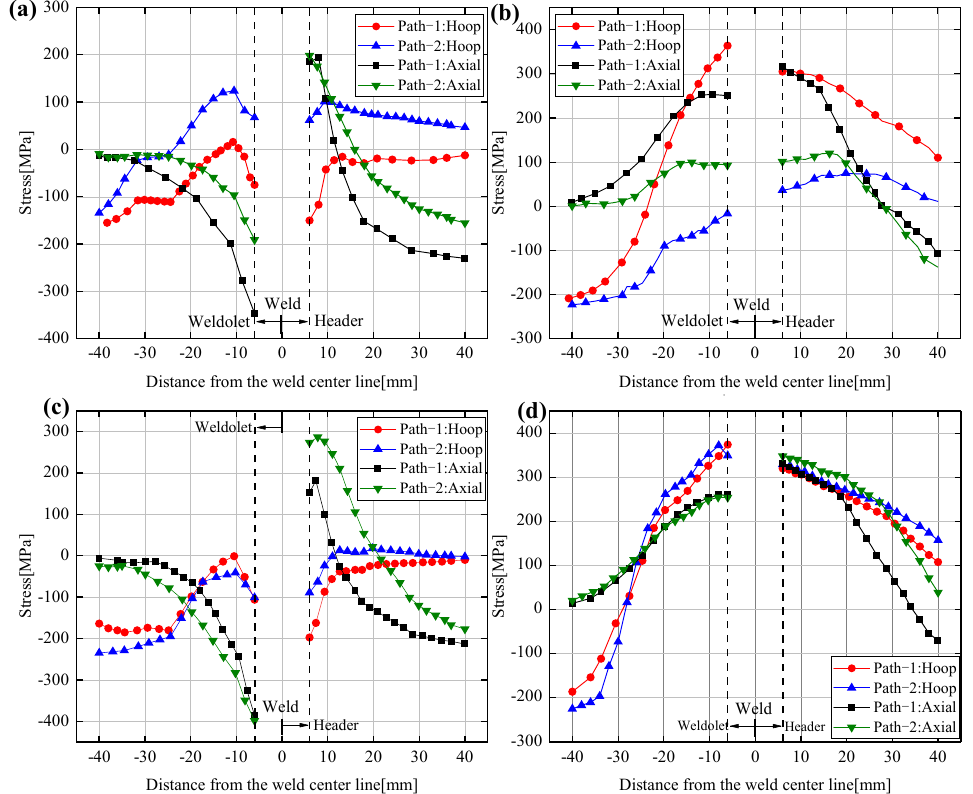
Figure 14. Hoop and axial residual stress distribution for Case3 and Case6 at the 90° and 270° sections: ( a ) Outer surface of the 90° section, ( b ) inner surface of the 90° section, ( c ) outer surface of the 270° section, ( d ) inner surface of the 270° section.